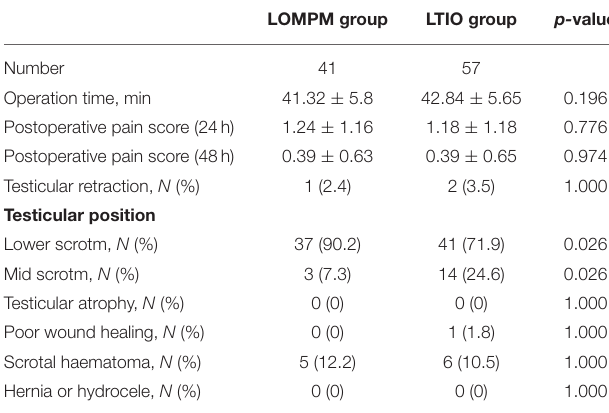
TABLE 1 | Comparison of preoperative, and intraoperative data between the two groups.